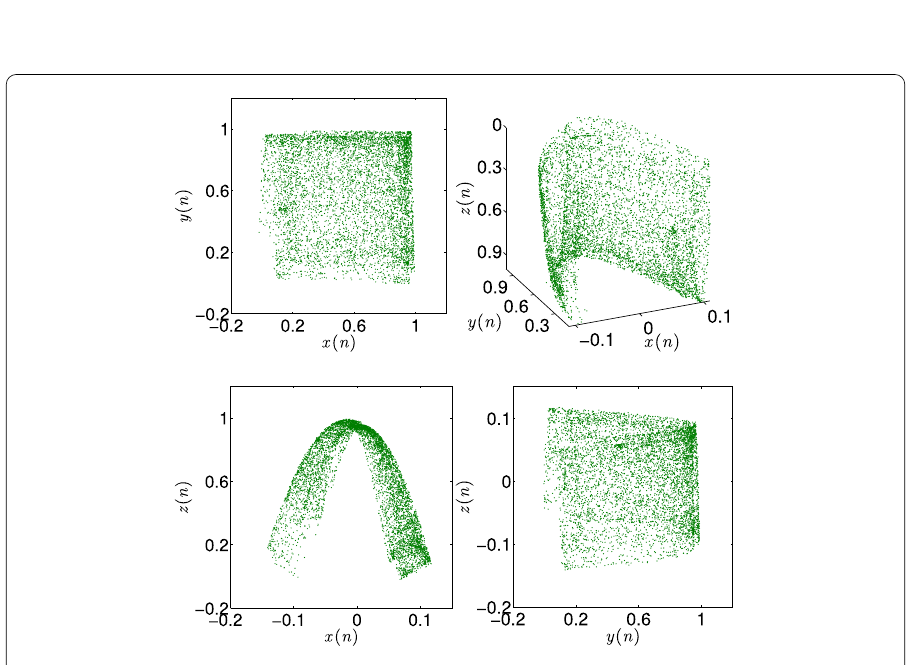
Figure 10 Phase portraits of the fractional order Rössler map for υ = 0.91